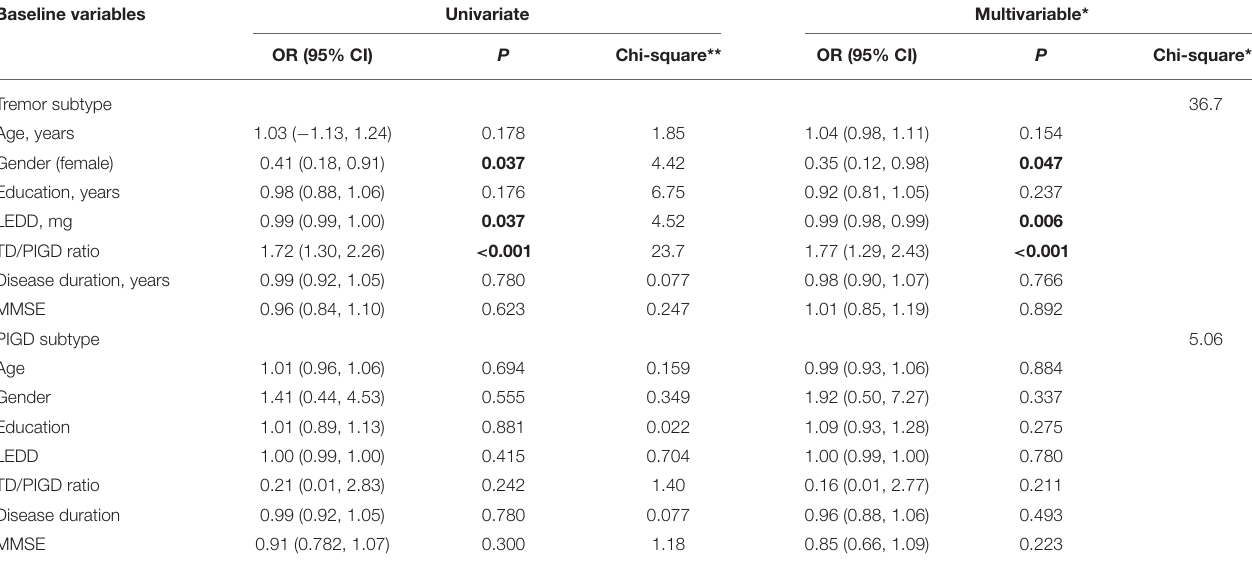
* Multivariable logistical regression model. Multivariable model is only provided for tremor-dominant subtype and PIGD subtype. ** Chi-square statistics with one degree of freedom is reported for each variable. LEDD, levodopa equivalent daily dose; MMSE, Mini-Mental State Examination; TD, tremor-dominant subtype; PIGD, postural instability gait subtype; OR, odds ratio; CI, confidence interval. Significant values are indicated in bold.